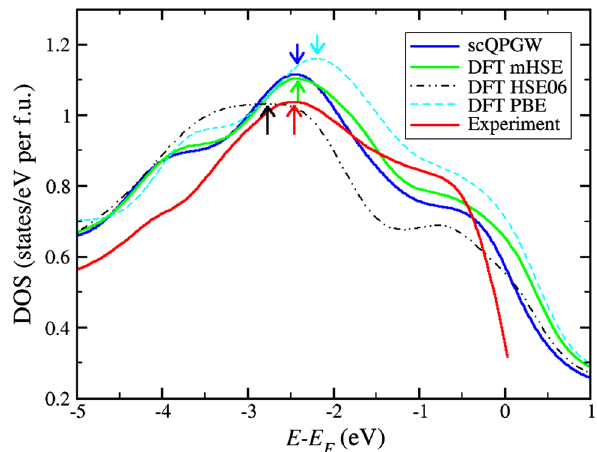
calculated by the 2